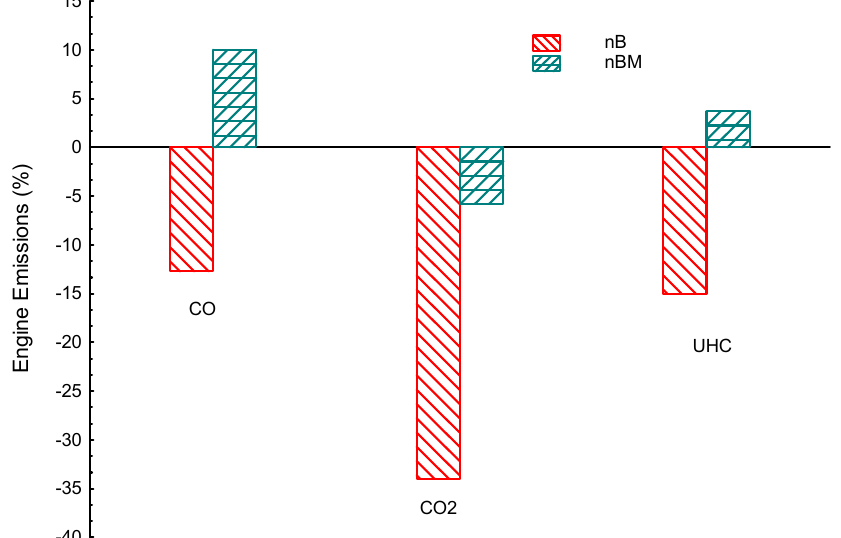
Figure 10. Comparisons of CO, CO 2 and UHC emissions for n-butanol–methanol (nBM) and n- butanol (nB) blended with gasoline and neat gasoline (baseline) in %.